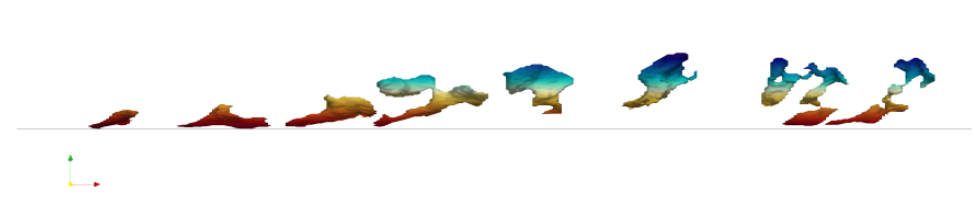
Figure 5. Representation of the shape and distance to the wall of an ejection through several steps of its